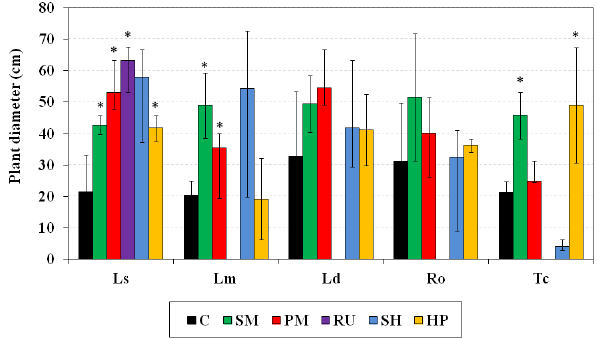
Figure 4. Maximum diameter of the canopy (in centimeters) 30 months following transplantation (May 2014). C: soil afforested